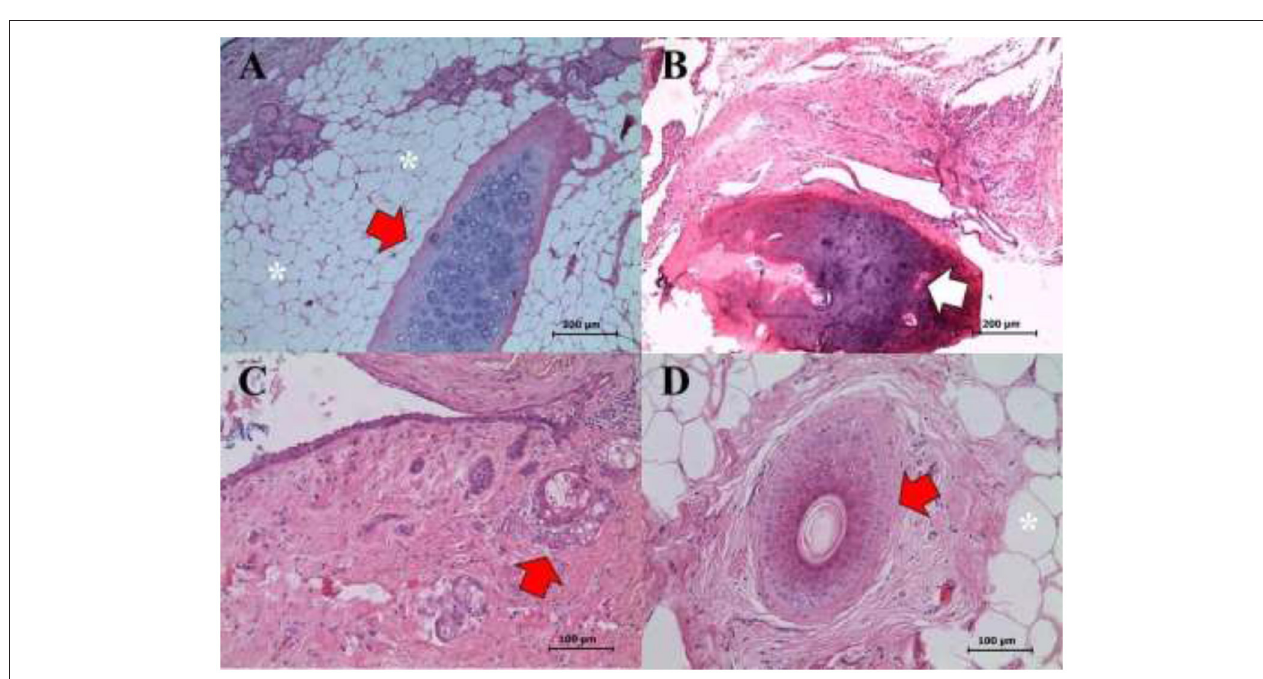
FIGURE 4 | Right ovary. Mature and well-differentiated teratoma showing the following structures: (A) Cartilage (red arrow), glandular tissue (see eosinophilic content in the upper left corner), and adipose tissue (asterisks) (H&E staining, 400X). (B) Bone tissue (white arrow) (H&E staining, 200X). (C) Cystic hair follicle (red arrow) (H&E staining, 400X). (D) Cartilage (red arrow), and adipose tissue (asterisks) (H&E staining, 400X). Scale bars: 100 and 200 µ m.